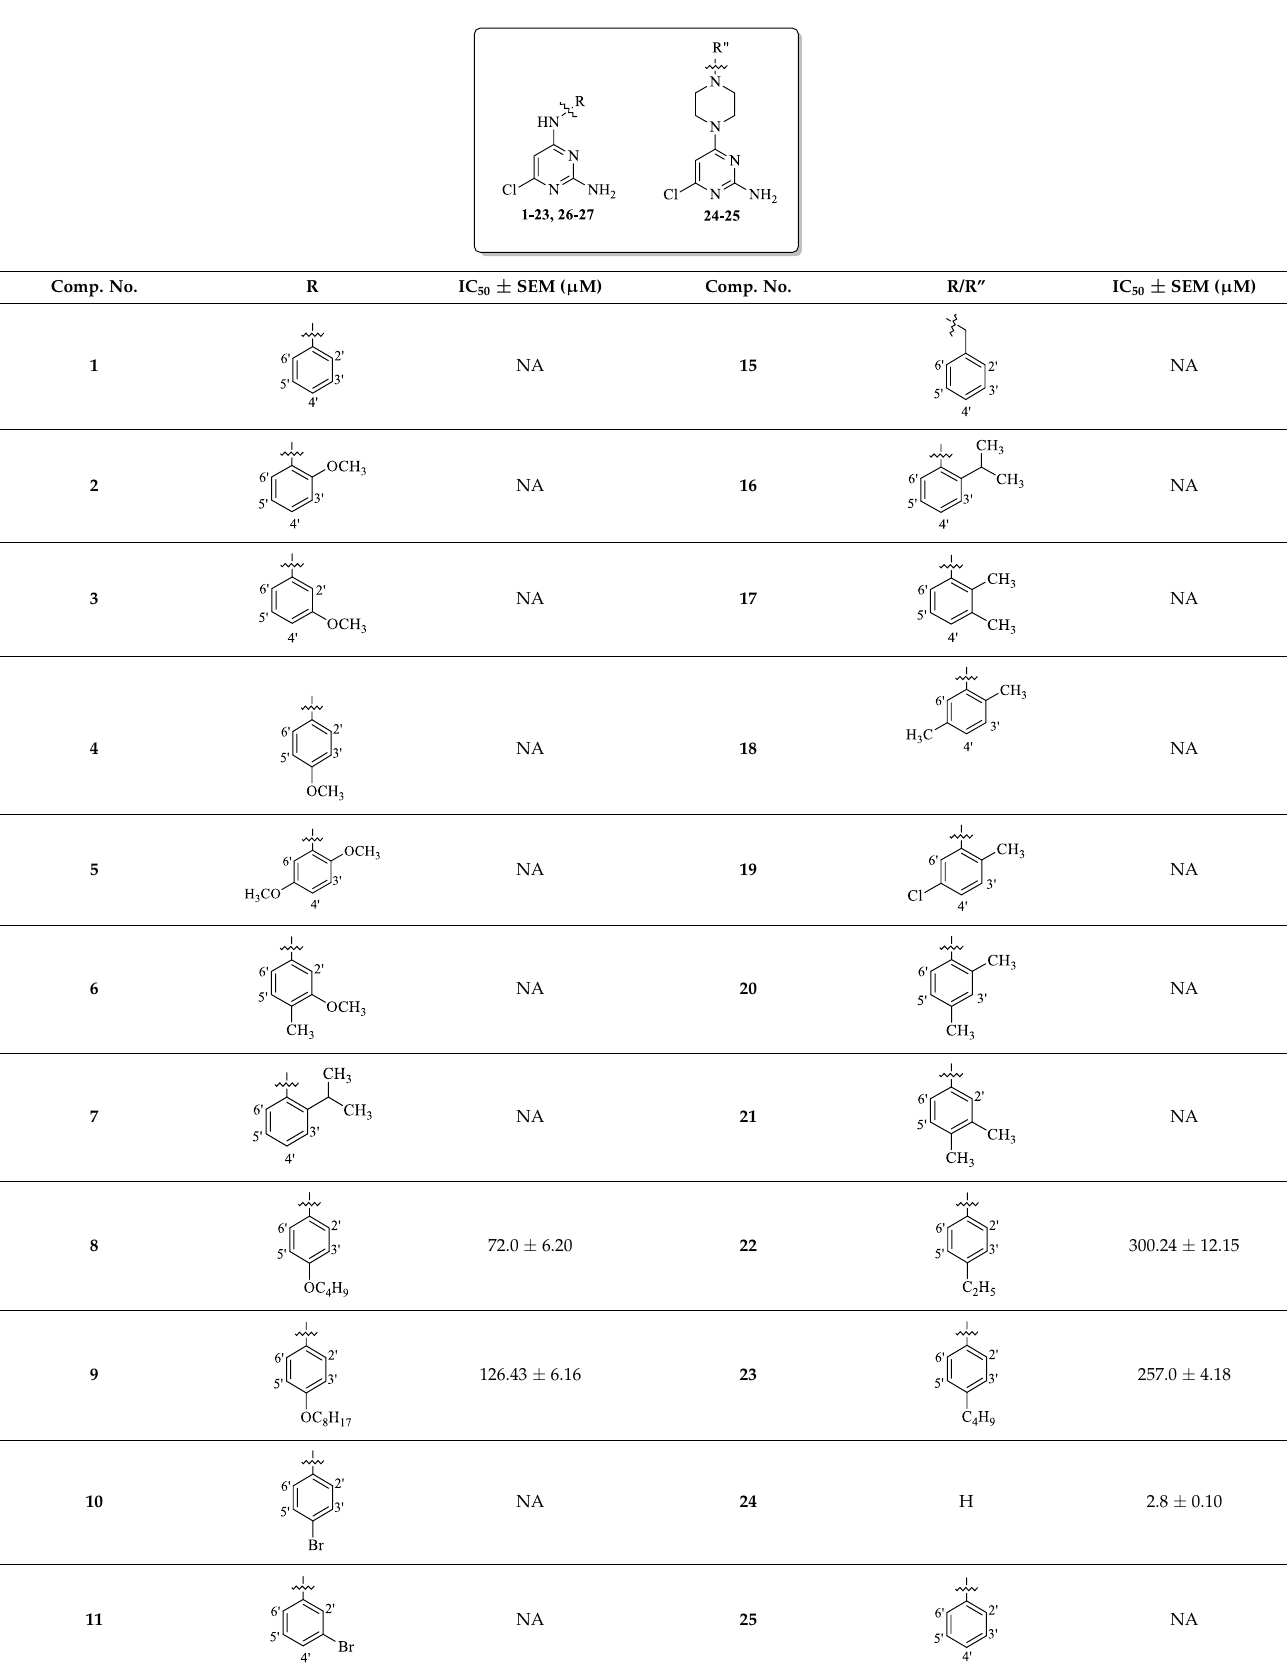
Table 1. List of synthesized compounds 1–27 and their in vitro β -glucuronidase inhibition activity.